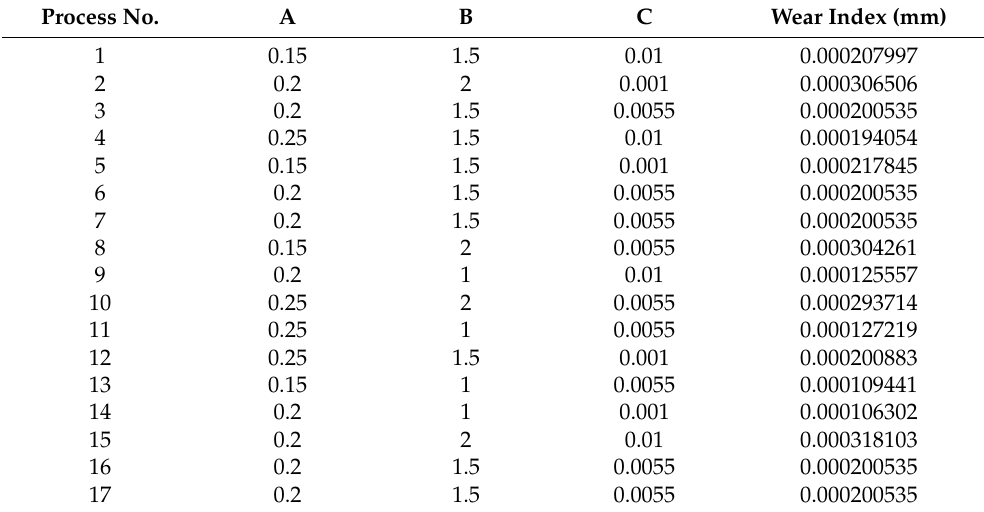
Table 4. BBD and results.